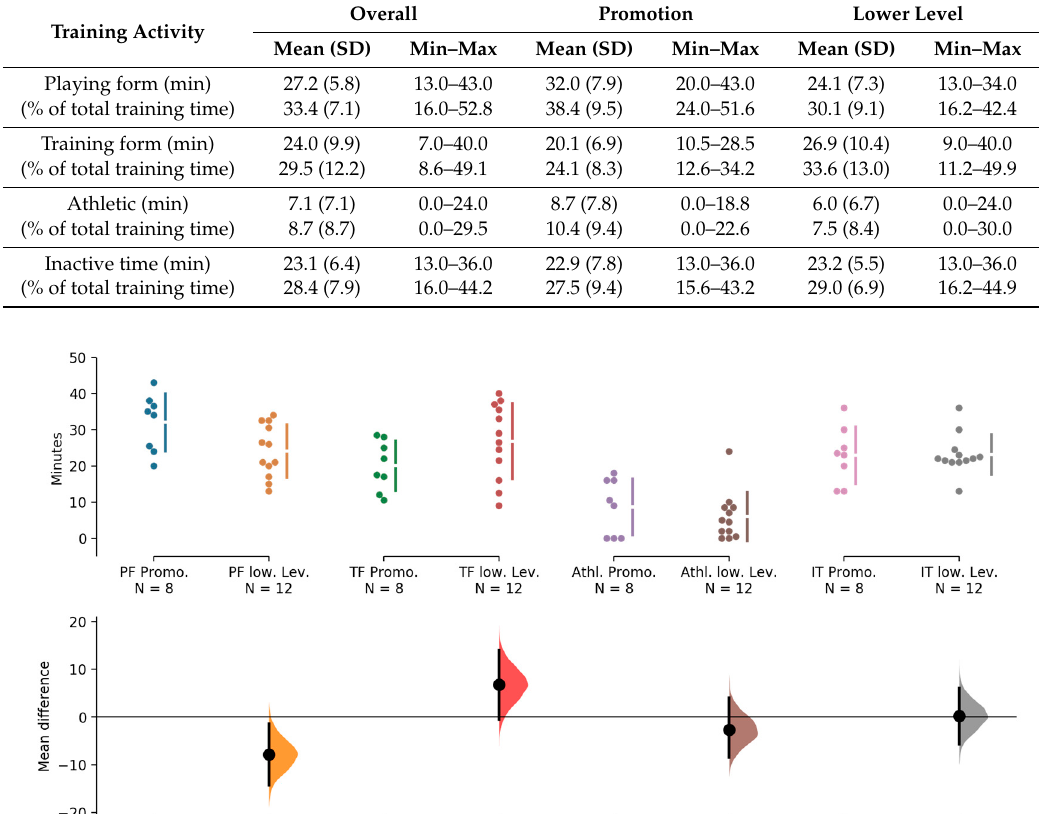
(% of total training time) 29.5 (12.2)